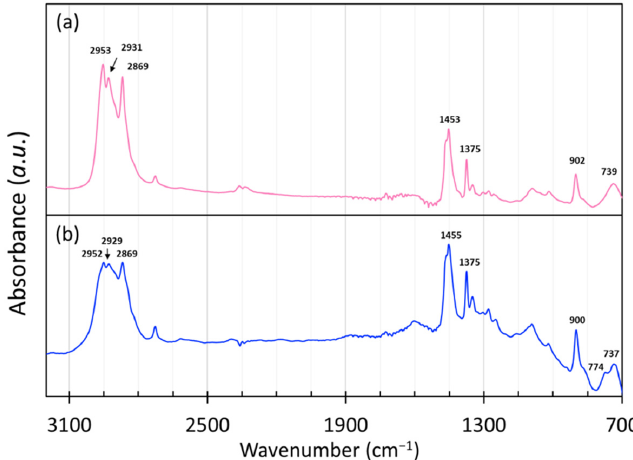
Figure 6. IR spectra of ( a ) Fraction B [C 60 ( n C 3 H 7 ) 22 ] and ( b ) Fraction C [C 60 ( n C 3 H 7 ) 20 ].